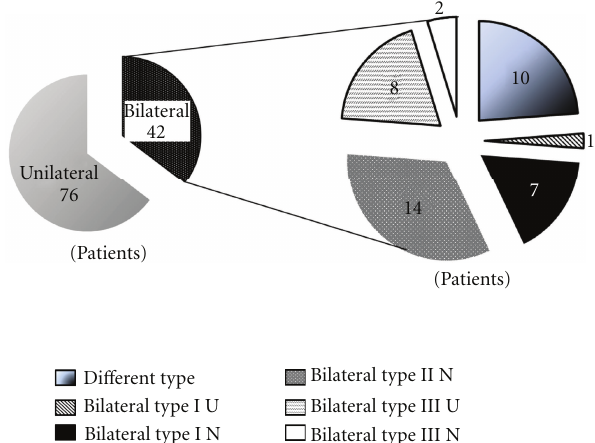
Figure 5: The di ff erence in the type of deformity between the right and left shoulder in patients with deformity of both shoulders.